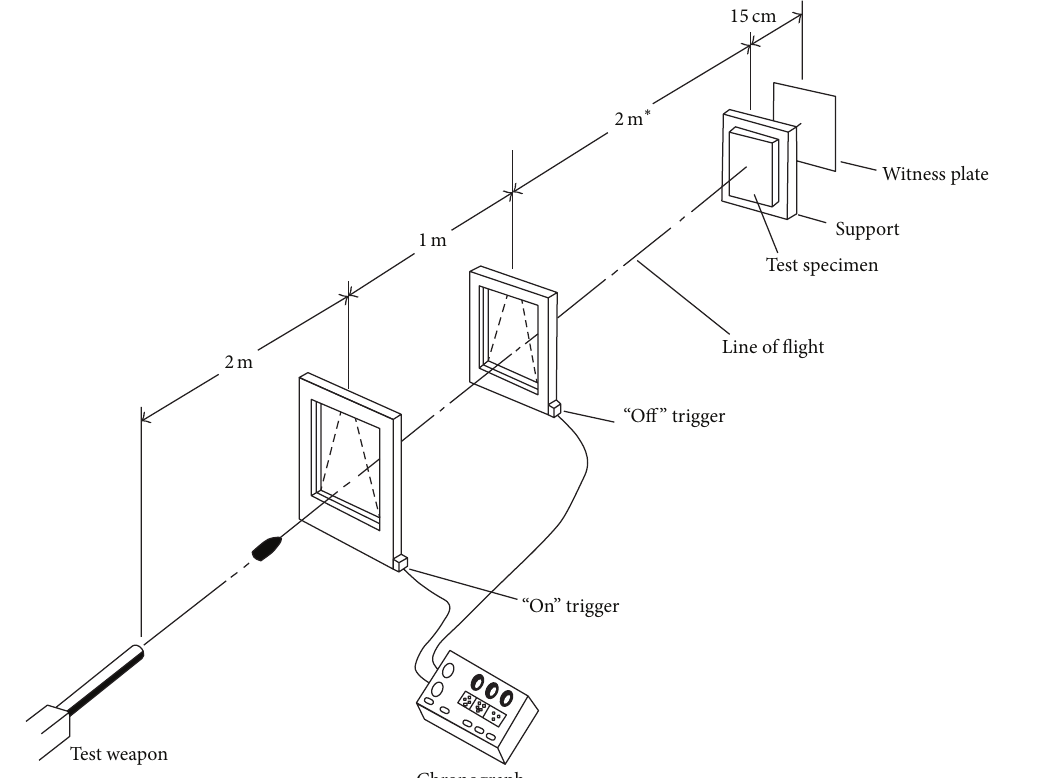
Figure 1: Ballistic test setup according to NIJ Standard 0108.01 [5].